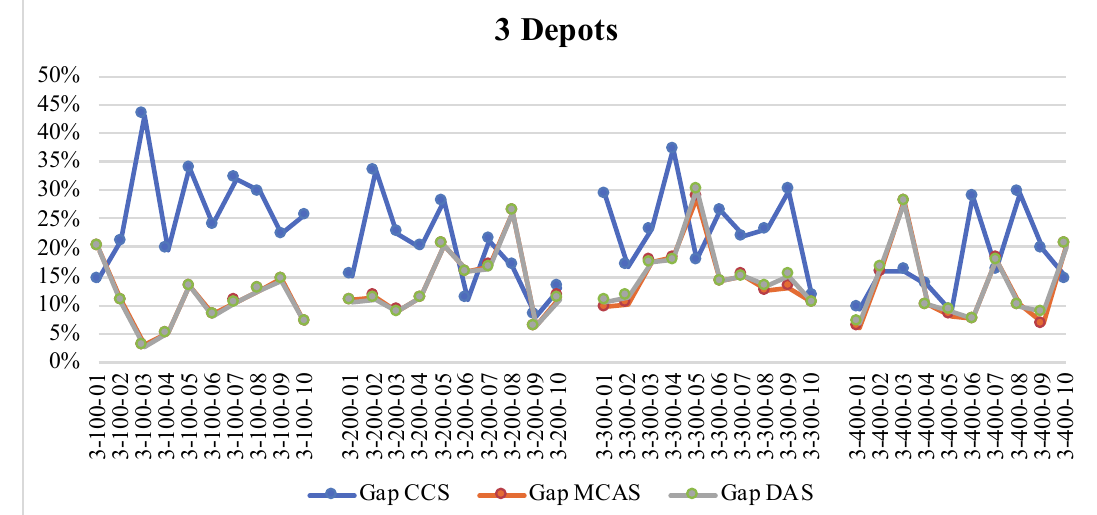
Fig. 12. Gap constructive procedures vs. optimal solution (3 Depots)